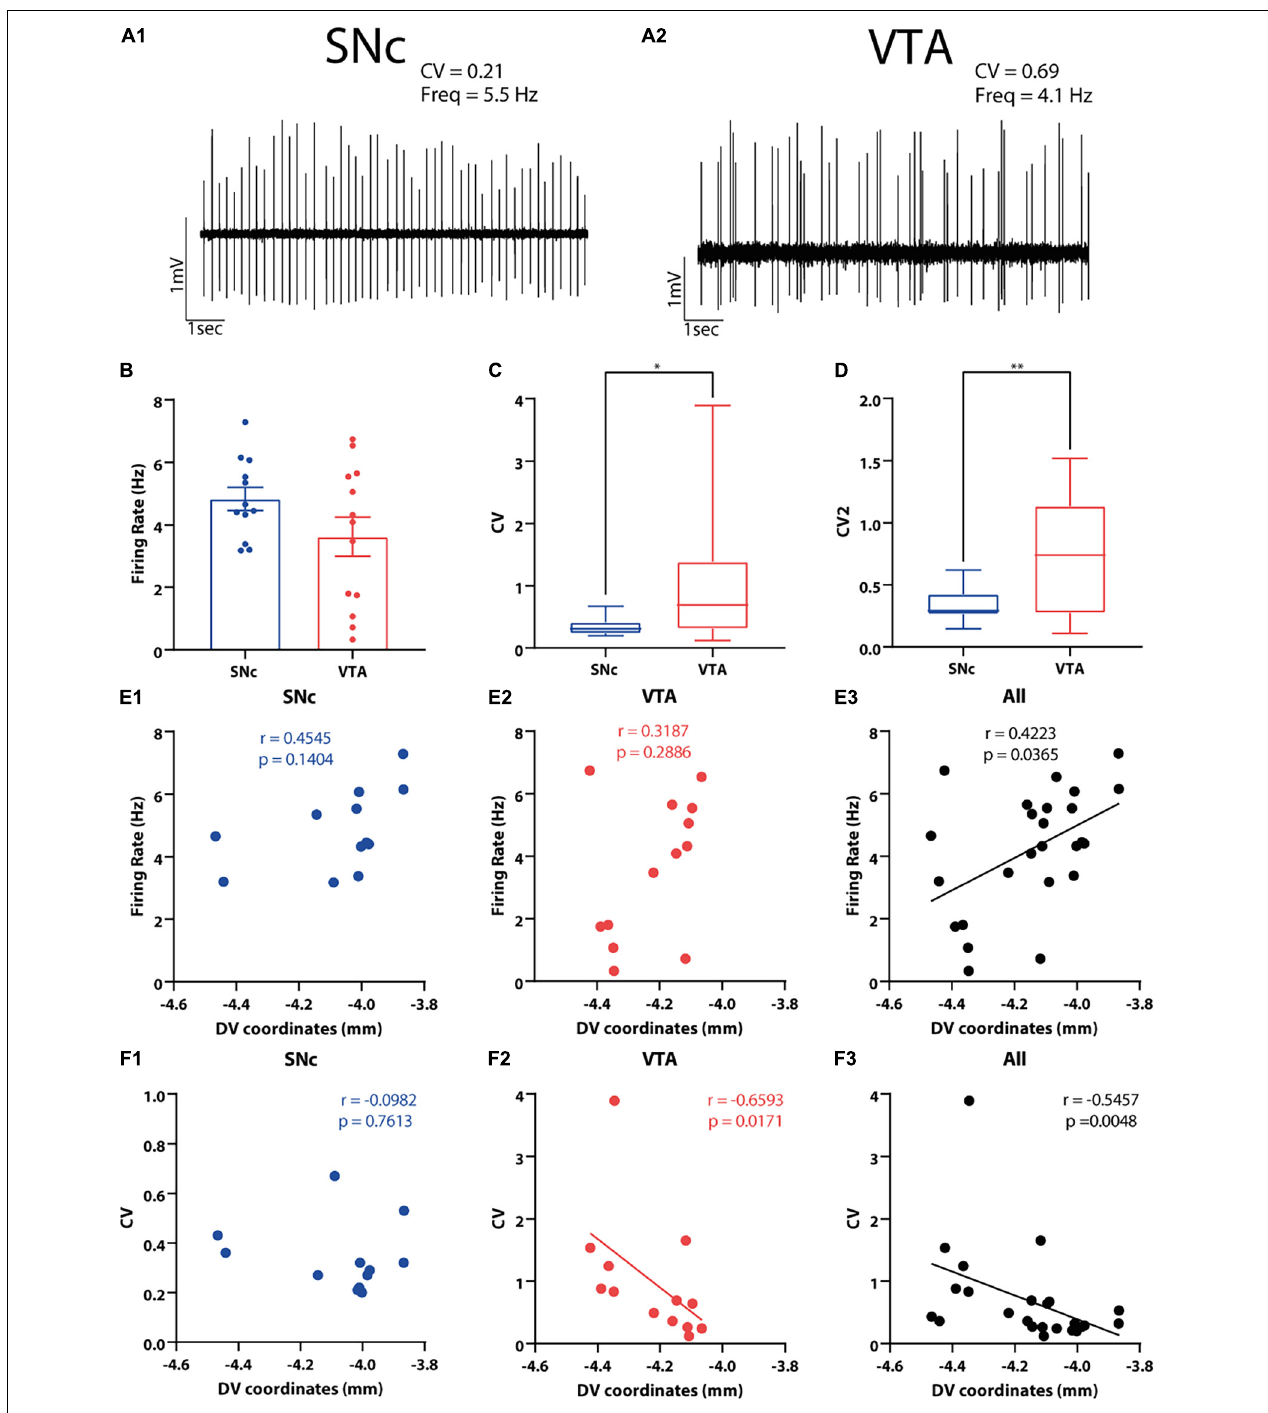
FIGURE 4 | In vivo electrophysiological characteristics of SNc and VTA DA neurons and their correlation with cell body position in the DV axis. (A1,A2) Examples of in vivo extracellular recordings of (A1) SNc and (A2) VTA neurons. (B–D) Electrophysiological properties of SNc and VTA DA neurons were compared. Firing rate (B) and the firing regularity measures (C) CV and (D) CV2 are shown. ∗ p < 0.05, ∗∗ p < 0.01, unpaired t -test (CV2) or Mann–Whitney U test (CV). (E1–F3) Correlations between electrophysiological variables and DV cell body position of 3D-reconstructed SNc and VTA DA neurons. Positive correlation was found between firing rate and DV coordinates when all neurons were analyzed together (E3) , but this was not observed in each area separately (E1,E2) . Negative correlation was observed between CV and DV coordinates used and for VTA (F2) and for all neurons (F3) but not for SNc DA neurons (F1) . Figure only shows correlations between electrophysiological variables and DV position. Refer to the Results section and Supplementary Table 3 for correlations between electrophysiological variables and ML and AP axes position.